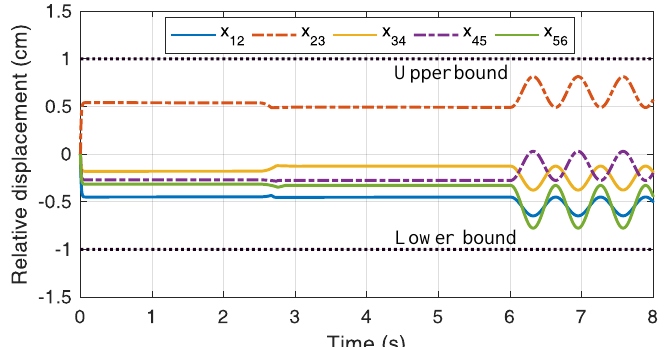
Figure 13. Relative displacement curves of each carriage without the anti-disturbance control compo- nent in case 3.